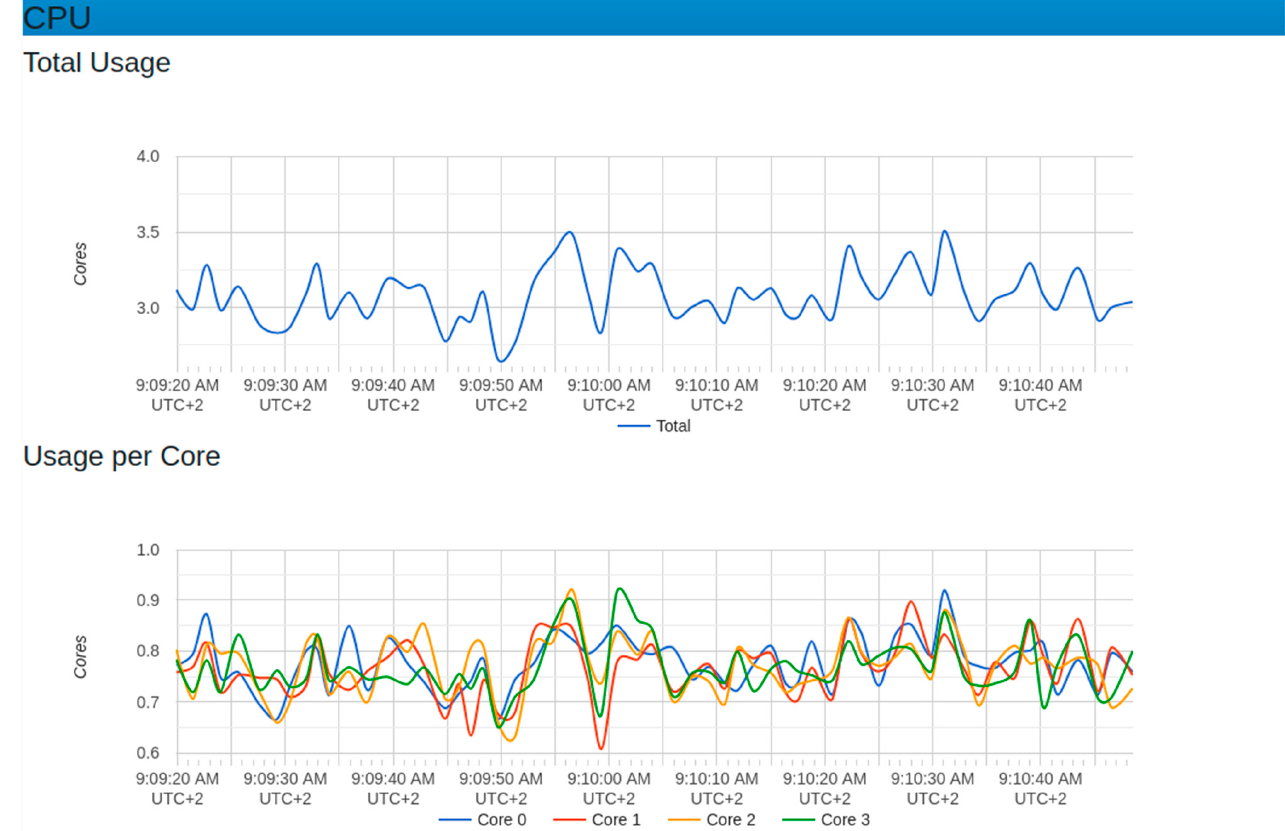
Figure 15. CPU resources with 10,000 generated sensor requests.